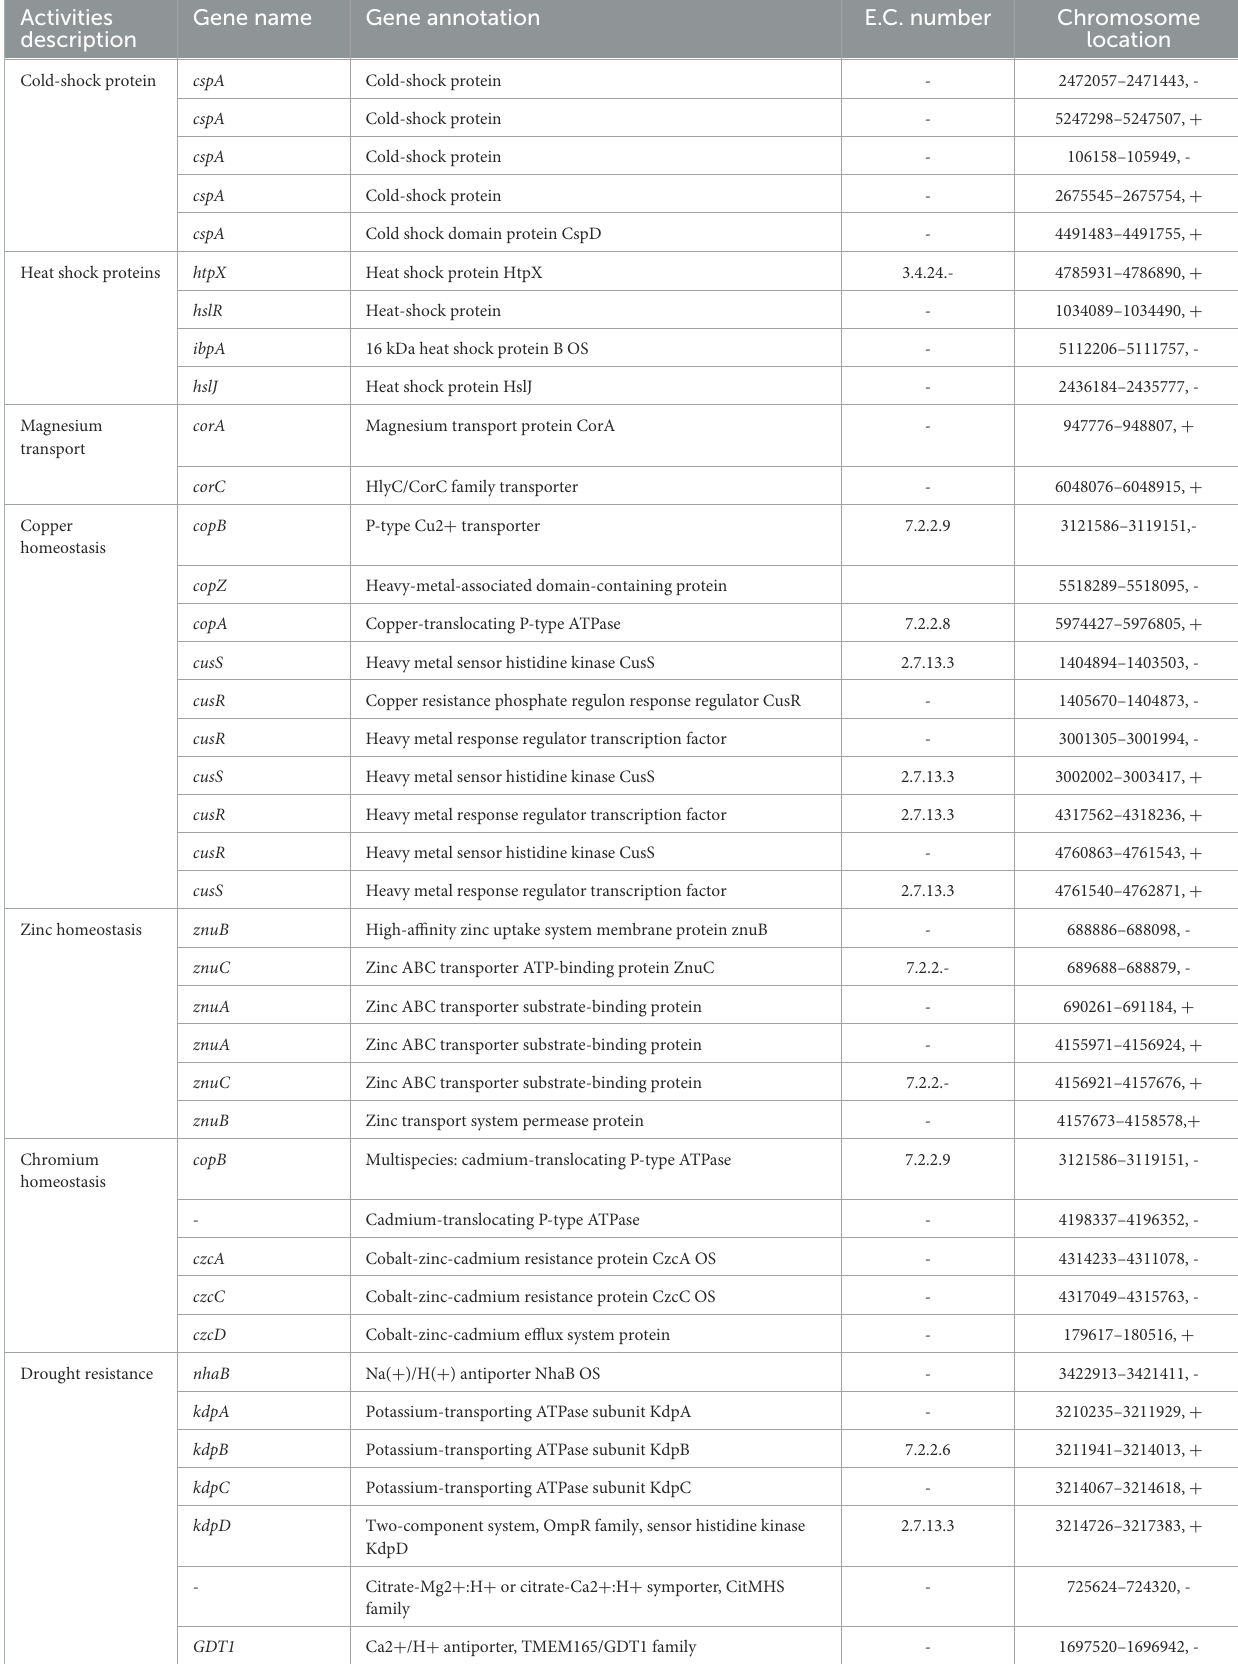
TABLE 6 Genes involved in different abiotic stresses in Pseudomonas aeruginosa DJ06